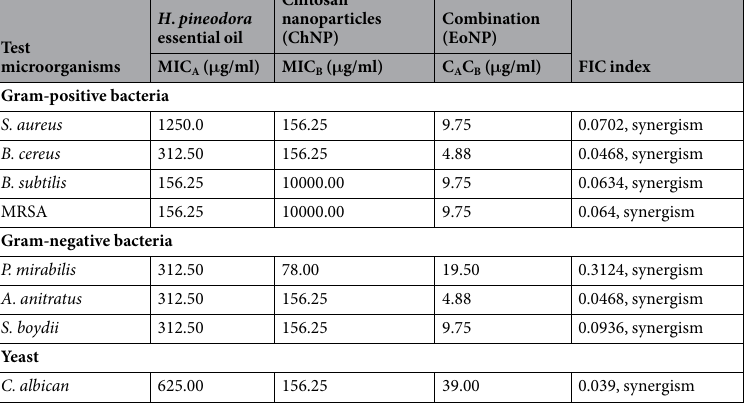
Table 4. Fractional inhibitory concentration (FIC) indices of ChNP and H. pineodora essential oil using checkerboard assay.